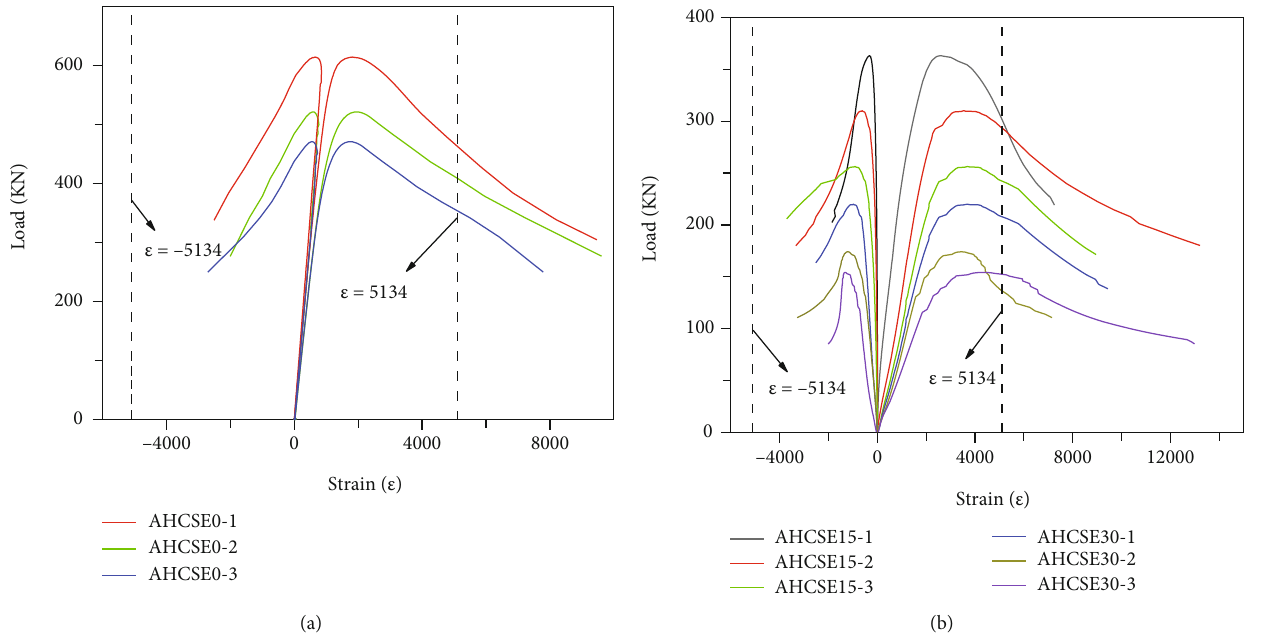
Figure 8: (a) Axial compression specimen. (b) Eccentric compression